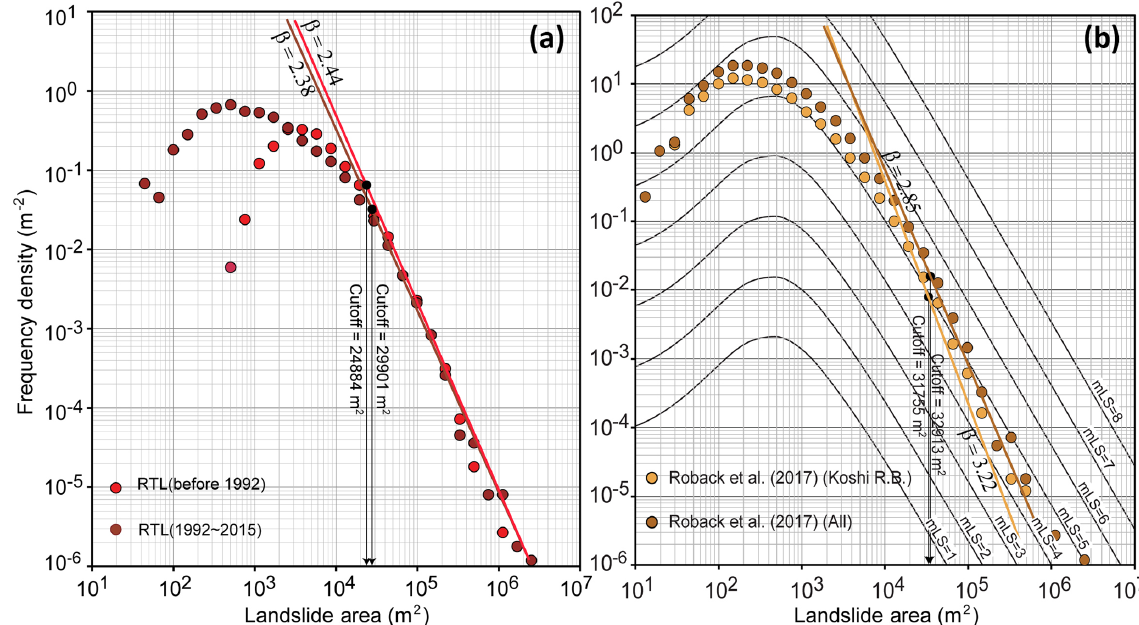
Figure 5. Landslide frequency – area distributions of (a) RTL inventories and (b) ETL inventories created for the Koshi River basin and ETL inventories created for the entire landslide-affected area of the 2015 Gorkha, Nepal, earthquake (Roback’s landslide inventory was validated). Cutoff and β values are calculated using the method proposed by Clauset et al. (2009). Table 1. Numbers for different types and sizes of landslides in the Koshi River basin. Rainfall-triggered landslides (RTLs) Earthquake-triggered landslides (ETLs) All sizes Small size Large size All sizes Small size Large size Total 5858 5267 591 14127 13981 146 Modeling 3515 3160 355 8476 8388 88 Validation 2343 2107 236 5650 5593